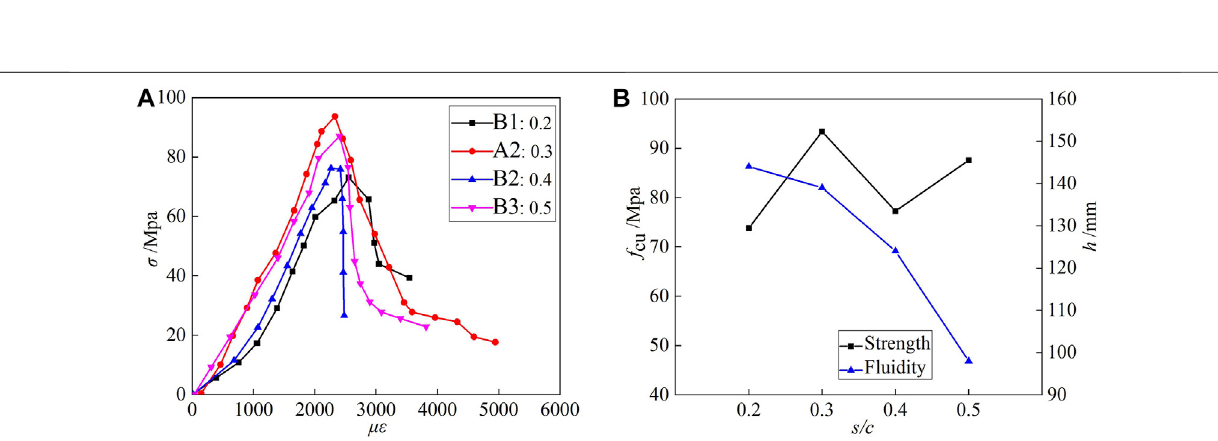
FIGURE5| Thein fl uenceofdifferentwatertobinderratiosonRPCmechanicalproperties. (A) Stress-straincurvesofRPCspecimenswithdifferentwatertobinder ratios. (B) Ultimate compressive strength and mixture fl uidity of RPC with different water to binder ratios.